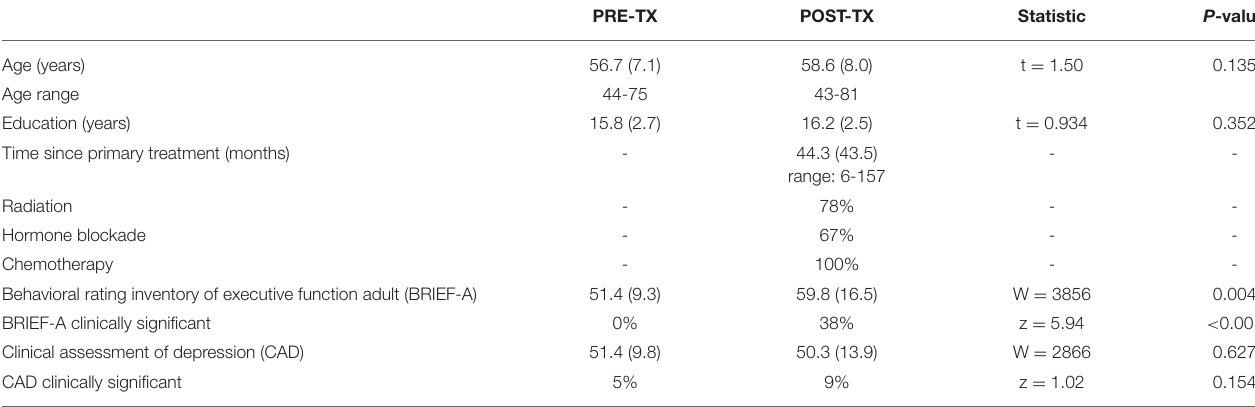
TABLE 1 | Participant characteristics and behavioral